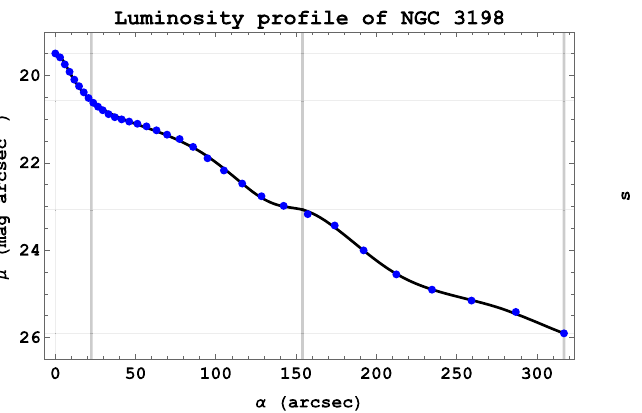
Fig. 6 The left-hand side graphic shows the luminosity profile of NGC 3198 adjusted along the major galactic radius. The line in the graphic corresponds to the adjusted luminosity and the dots to the values listed byKent[34].Theright-handsidegraphicshowstheadjustmentobtained using two eighth-order polynomial approximations for the Sérsic index,